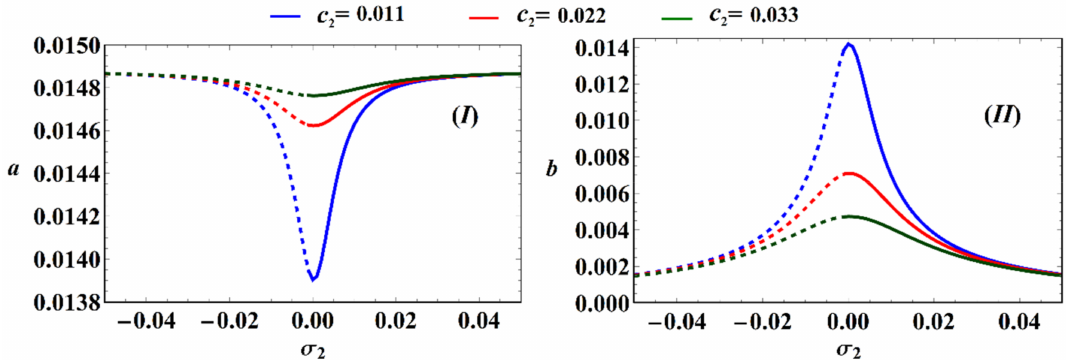
Figure 17. The frequency response of: ( I ) a ( σ 2 ) and ( II ) b ( σ 2 ) when σ 1 = − 0.001, W = 0.448 and c 1 = 0.001.